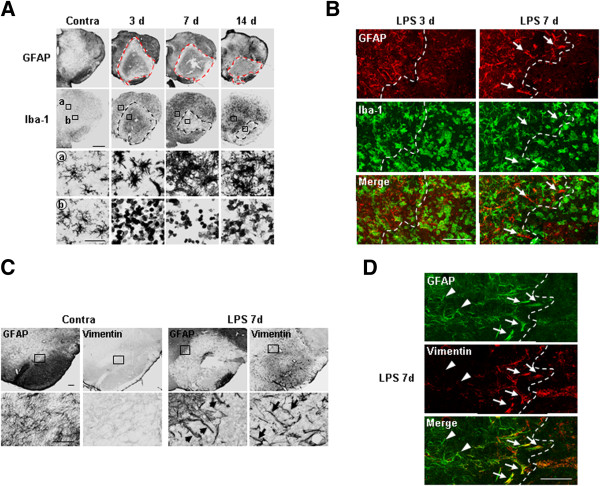
Possible spatial and temporal correlation between astrocytes and round Iba-1+ cells in the injured brain. Brain sections (30 μm) were obtained at the indicated times after LPS injection. (A, C) Immediately adjacent serial sections were stained with GFAP, Iba-1, and Vimentin antibodies, respectively. Lower panels are higher magnification of boxed areas in upper panels. (B, D) Sections were double-labeled with GFAP/Iba-1 (B) or GFAP/Vimentin (D). Arrows indicate astrocyte processes protruded towards monocytes (B, C). Arrows and arrowheads indicate Vimentin+ astrocytes near monocytes and Vimentin- astrocytes far from monocytes, respectively (D). Dotted lines in (A, B, and D) indicate the borders where GFAP+ astrocytes were absent and/or Iba-1+ round monocytes were present. Data shown are representative of at least three independent experiments. In each experiment, three or more animals were used for each time point. Scale bars, 1 mm (A), 200 μm (upper panels in C), 100 μm (B, lower panels in C, and D), 50 μm (lower panels in A).